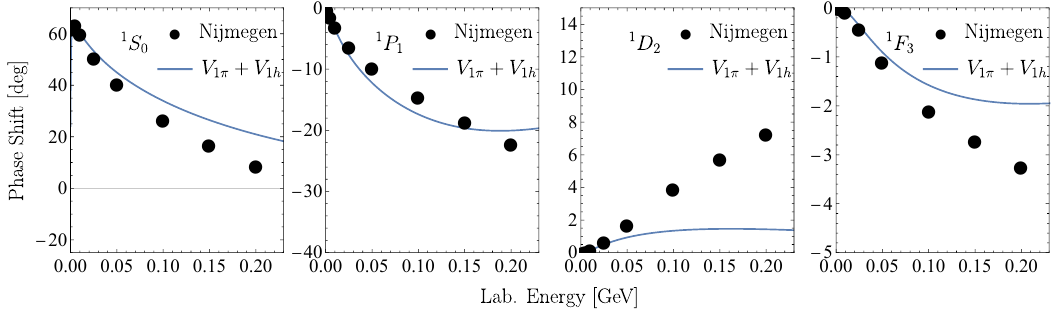
Figure 7 . S , P , D and F-wave phase shifts for the toy-model potential in eq. (5.15) in comparison with the corresponding spin-singlet NN phase shifts from the Nijmegen PWA [53].